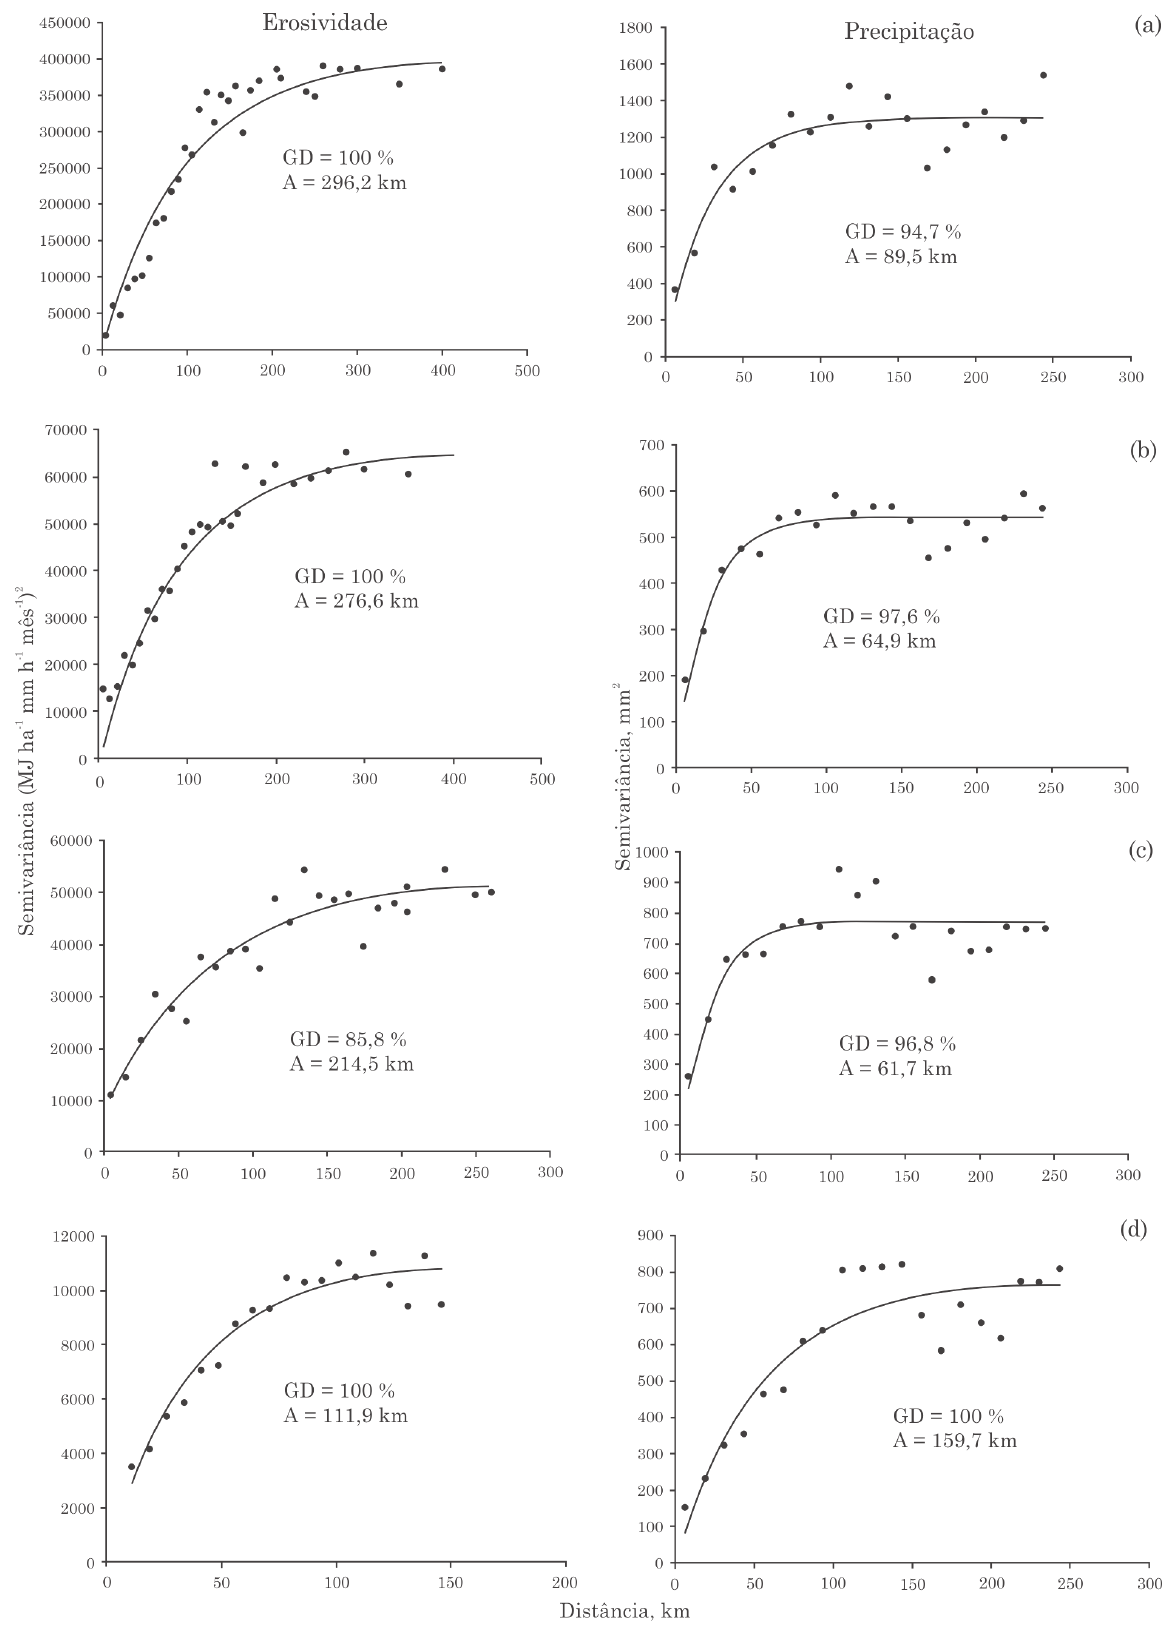
Figura 4. Semivariogramas ajustados para a erosividade e precipitação mensais para o Estado do Espírito Santo (a) janeiro; (b) fevereiro; (c) março; (d)